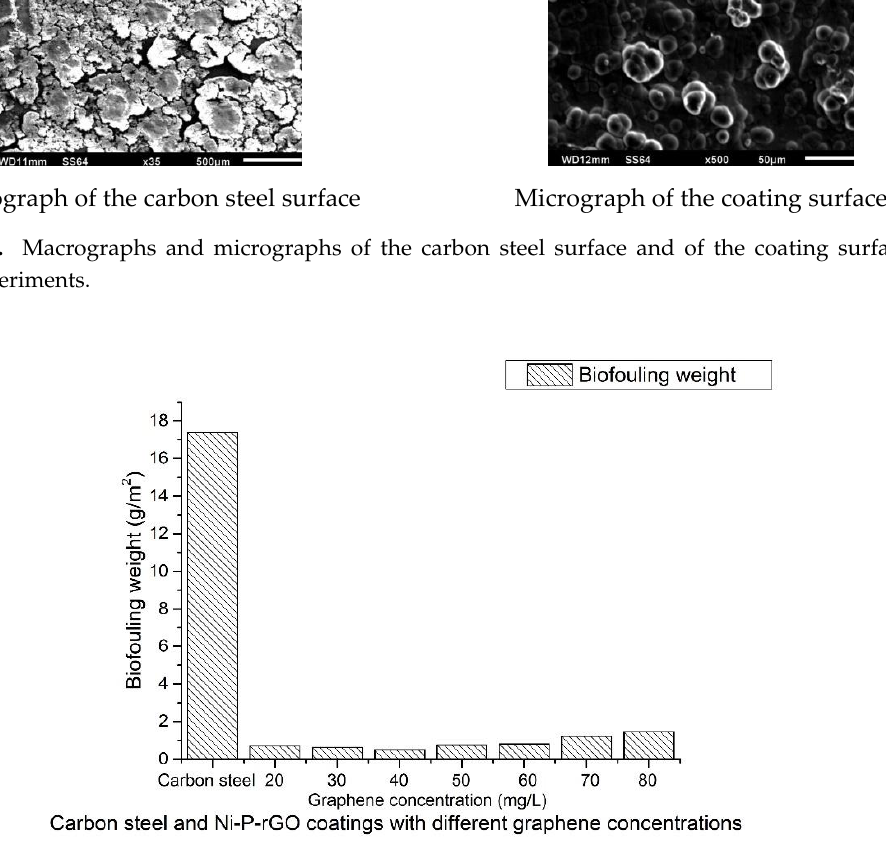
Figure 4. The iron bacteria biofouling weight of the carbon steel and the Ni–P–rGO coatings.